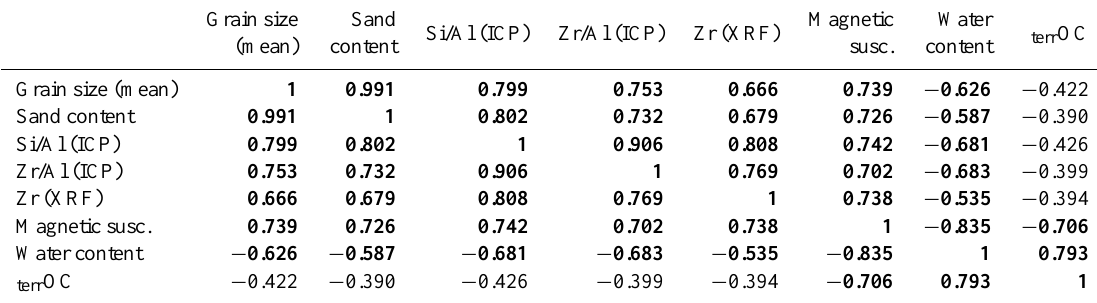
Fig. 5. High-resolution (3.5kHz) seismic profile across JPC14 coring site (line 5, from Fernandez et al., 2012). Sediment core JPC14 was projected using a p-wave velocity in the sediment of 1500ms − 1 . For location, see Fig. 1. 1 From Fernandez et al. (2012). Table 2. Pearson correlation matrix of selected variables measured on core JPC14. Only the 44 samples (1.5cm thick) used for ICP-AES analysis were used. For variables that were measured at a resolution < 1.5cm (XRF and MS), all the values corresponding to the 1.5cm thick sample were averaged. Values in bold are different from 0 with p <